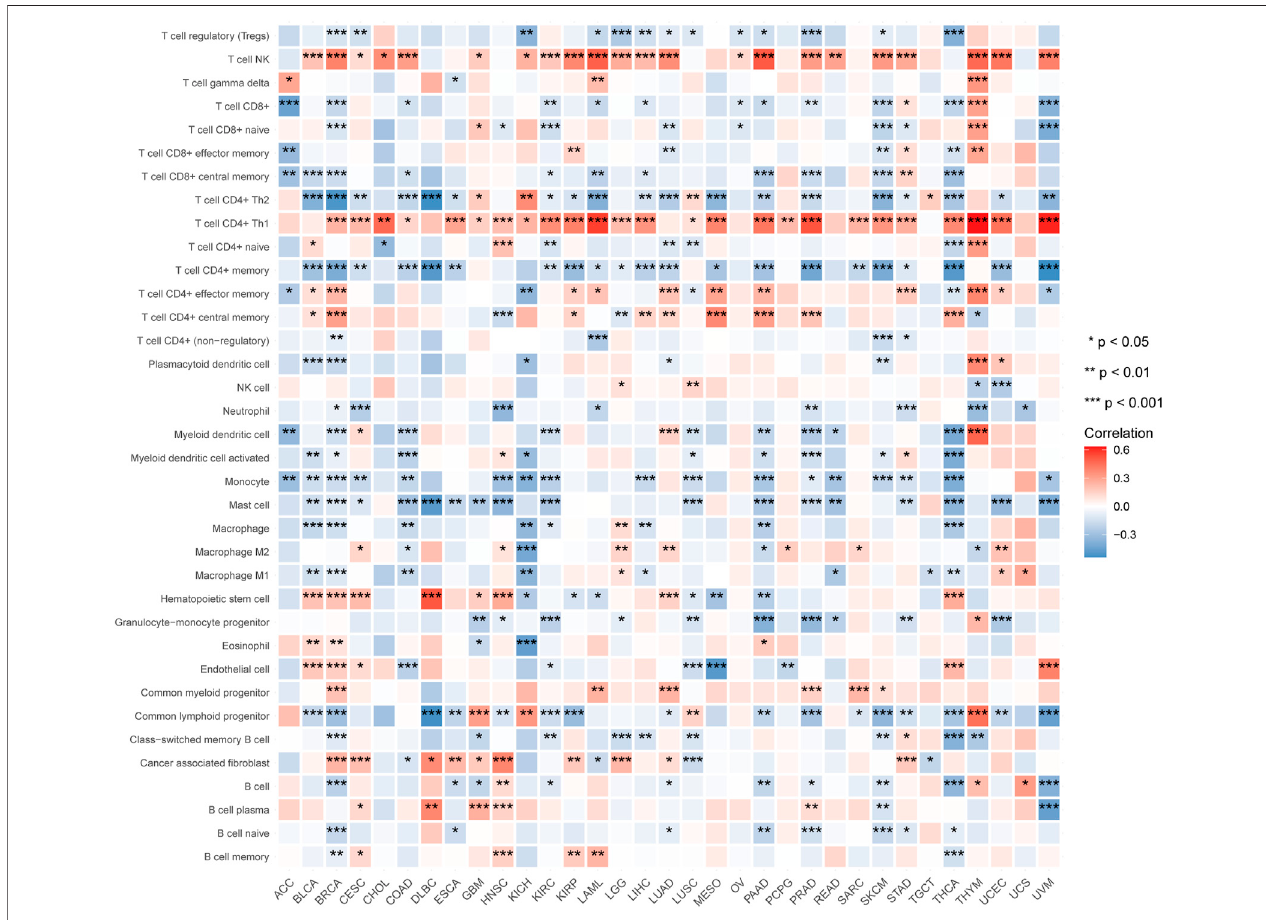
FIGURE 11 | Heat map of the correlations between ALKBH7 expression and immune cell subtypes in 33 types of cancer. “ * ” indicates p < 0.05, “ ** ” indicates p < 0.01 and “ *** ” indicates p < 0.001.